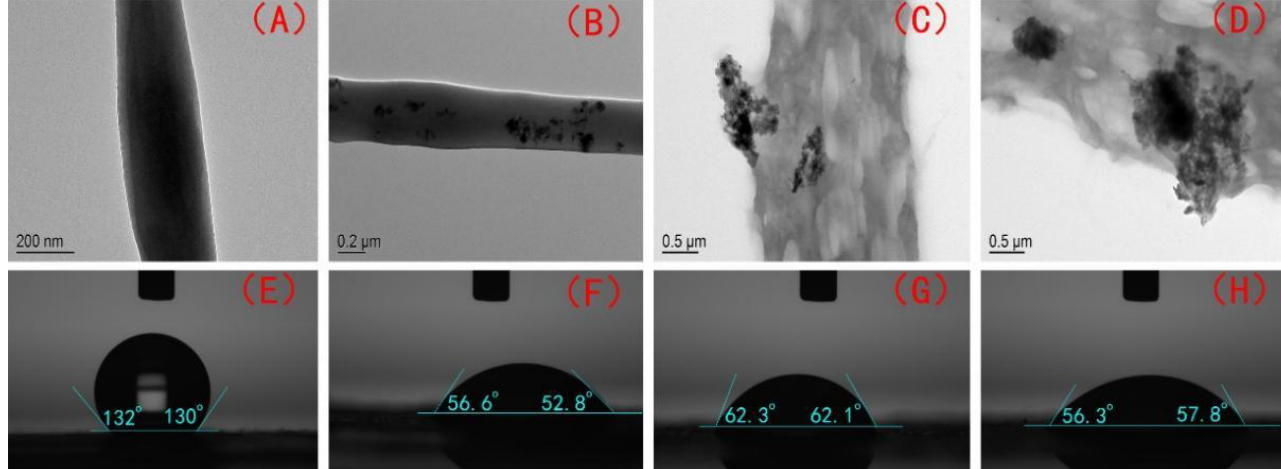
Figure 3. TEM images and water contact angle of PHBV ( A , E ), PHBV — GO/MXene 0.1% ( B , F ) PHBV — GO/MXene 0.5%